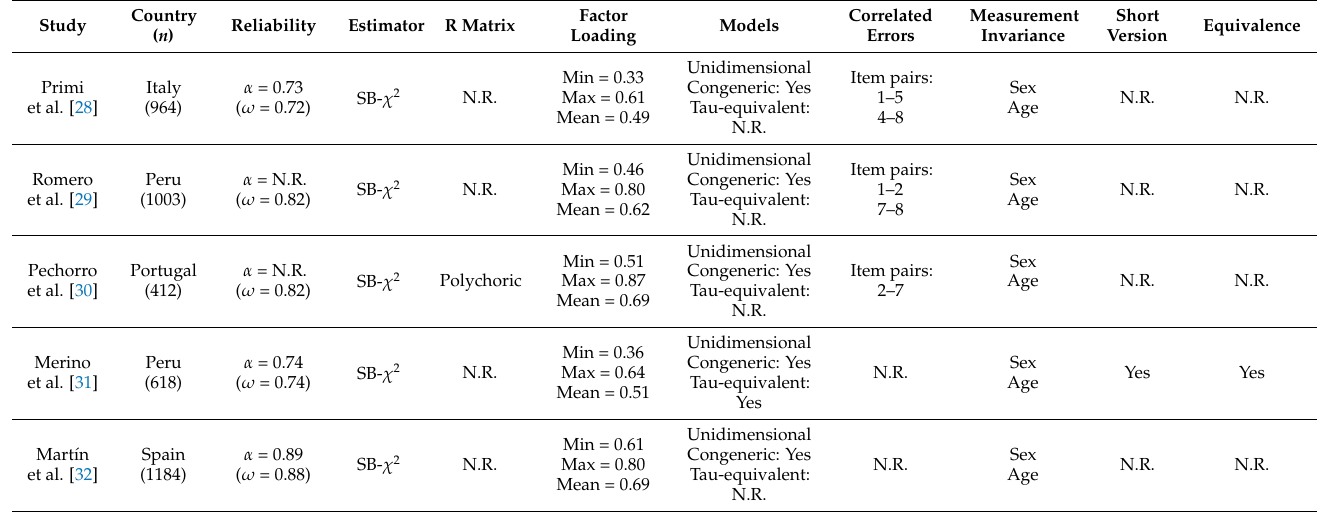
Table 1. Methodology of recent studies on the internal structure of the BSSS (adolescent